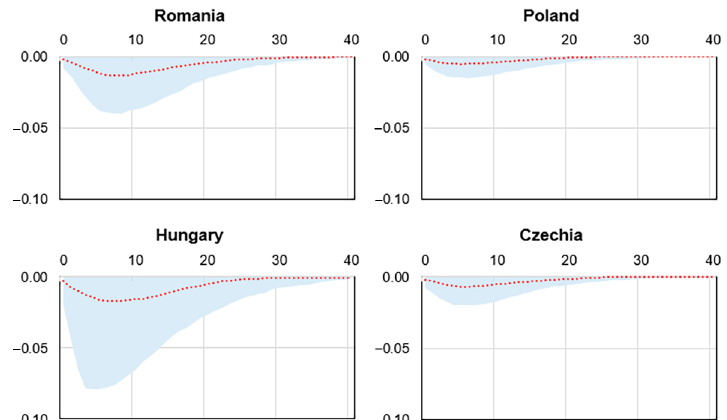
Figure 4. Impulse response functions of a one standard deviation supply shock in US on the selected CEE countries real economic growth (source: authors’